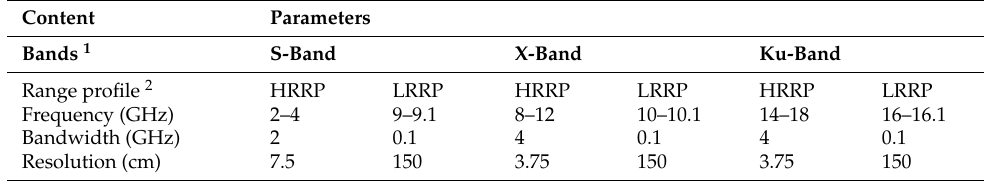
Table 1. Measured parameters of